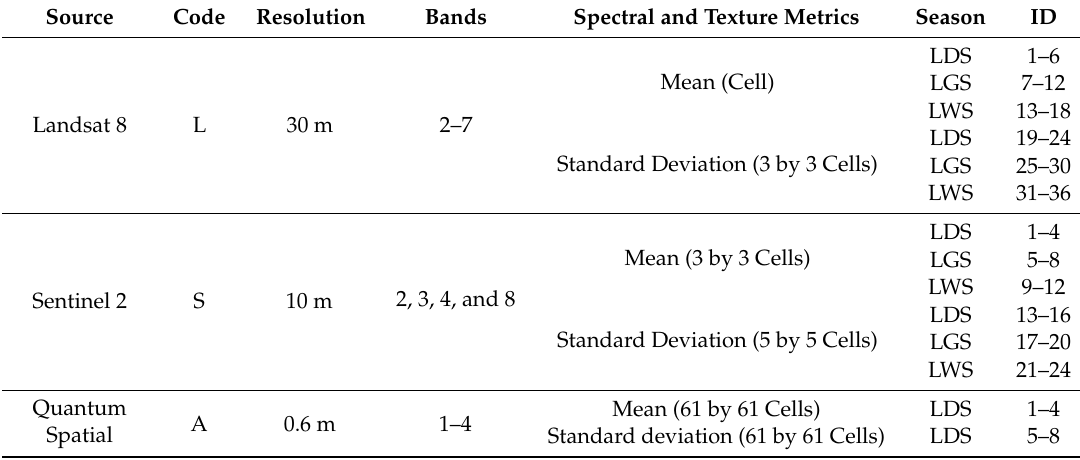
Table 2. Sources, spatial resolution, and labeling of imagery used in